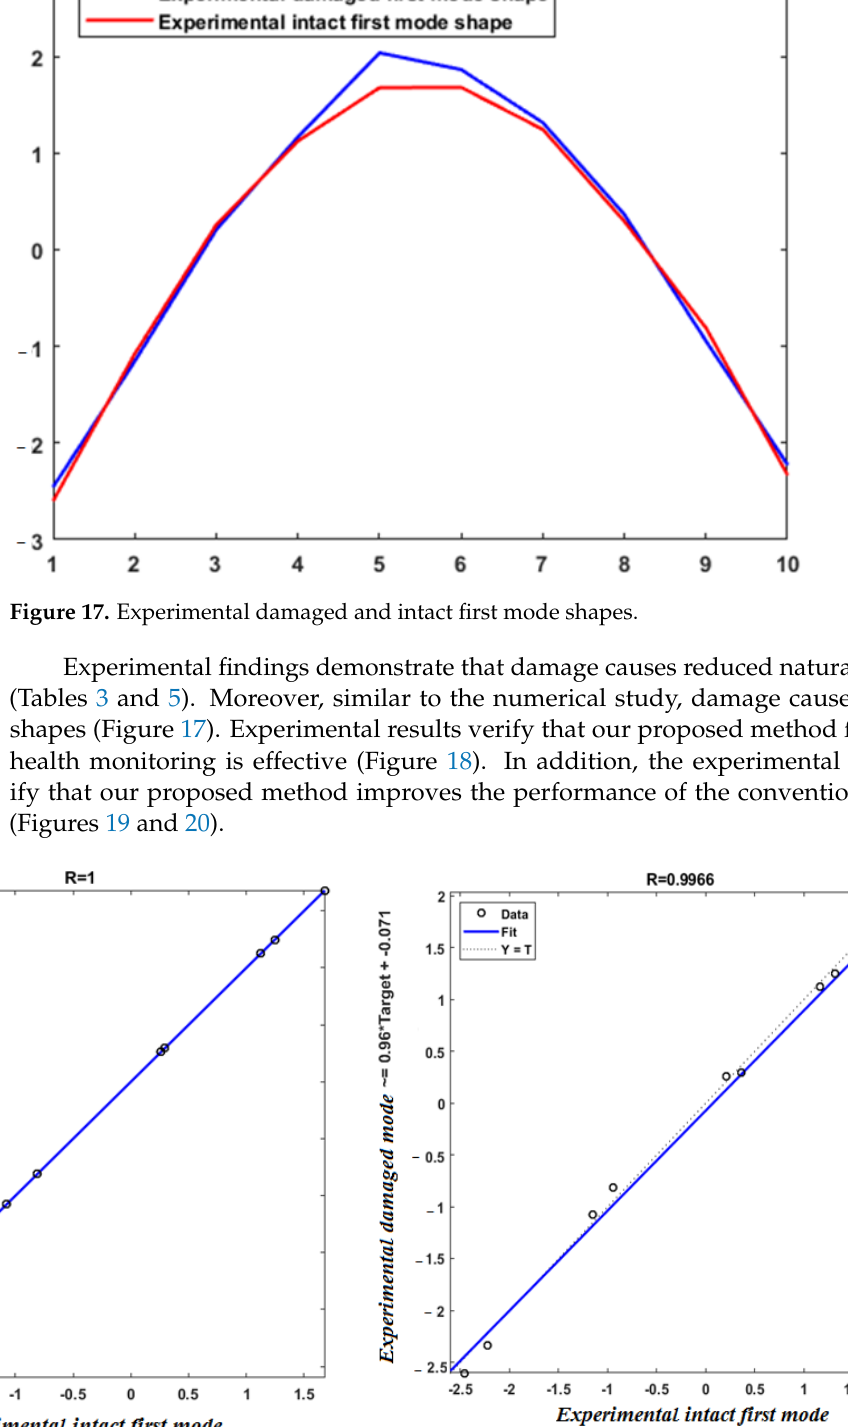
Figure 18. Regression plot for ( 𝐚 ) regression diagram for two experimental intact mode shapes and ( 𝐛 ) regression diagram for experimental damaged and intact mode shapes.